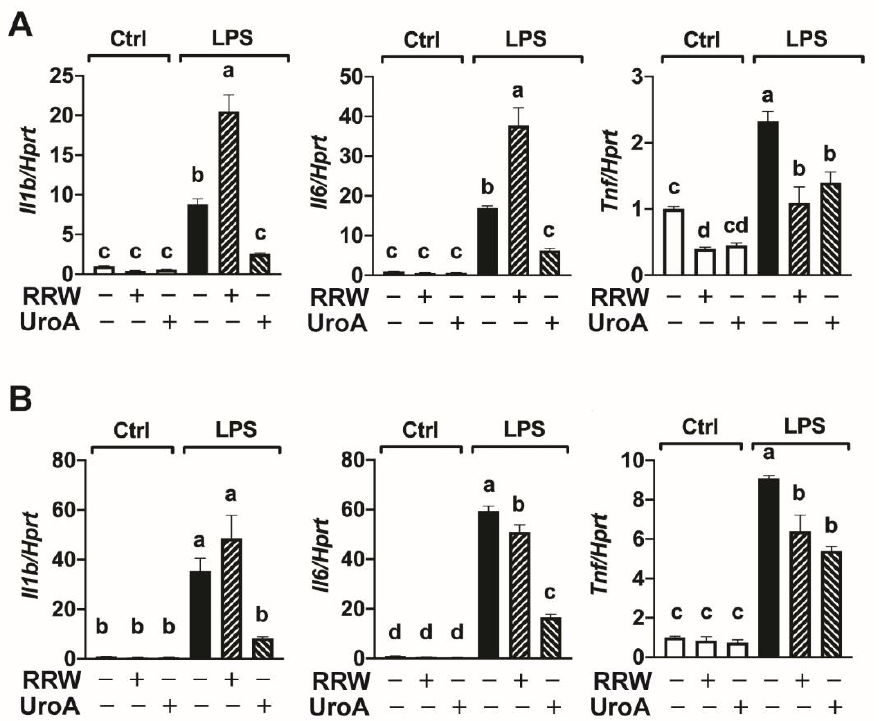
Figure 4. Urolithin A, but not whole red raspberry polyphenols, attenuated pro-inflammatory cytokine gene expression upon 12 and 24 h LPS treatment. ( A ) BV-2 cells treated with LPS (500 ng/mL) for 12 h with or without whole red raspberry polyphenols (10 µg/mL) or urolithin A (10 µM). Gene expression for Il1b, Il6 , and Tnf by RT-qPCR. ( B ) BV-2 cells treated with LPS (500 ng/mL) for 24 h with or without whole red raspberry polyphenols (10 µg/mL) or urolithin A (10 µM). Gene expression for Il1b, Il6 , and Tnf by RT-qPCR. All values represented as the mean ± SEM. Treatments with different letters indicate significant differences by one-way ANOVA, p < 0.05. LPS = lipopolysaccharide; RRW = whole red raspberry polyphenols; UroA = urolithin A.